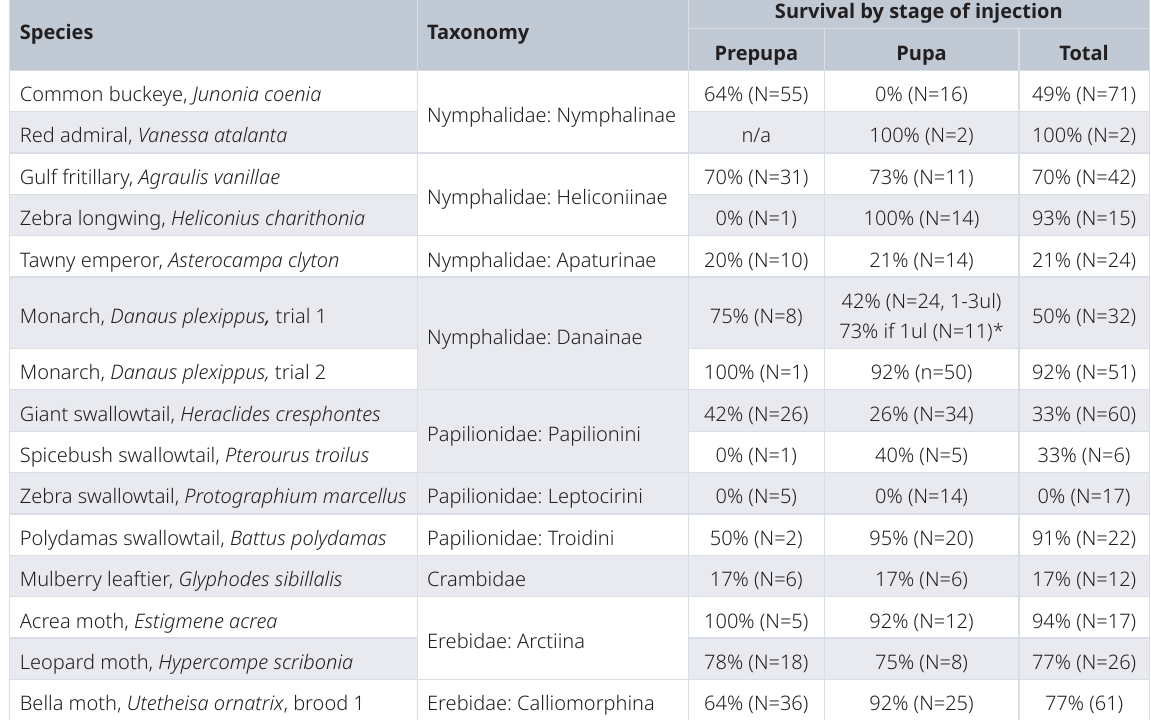
Table 1. Variation in survival after heparin injection, by species and developmental stage at time of injection.